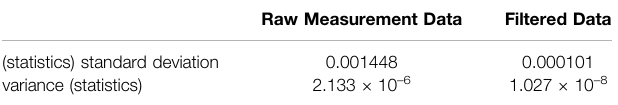
TABLE 1 | Statistical results of fi rst-order differential data before and after Kalman fi ltering.